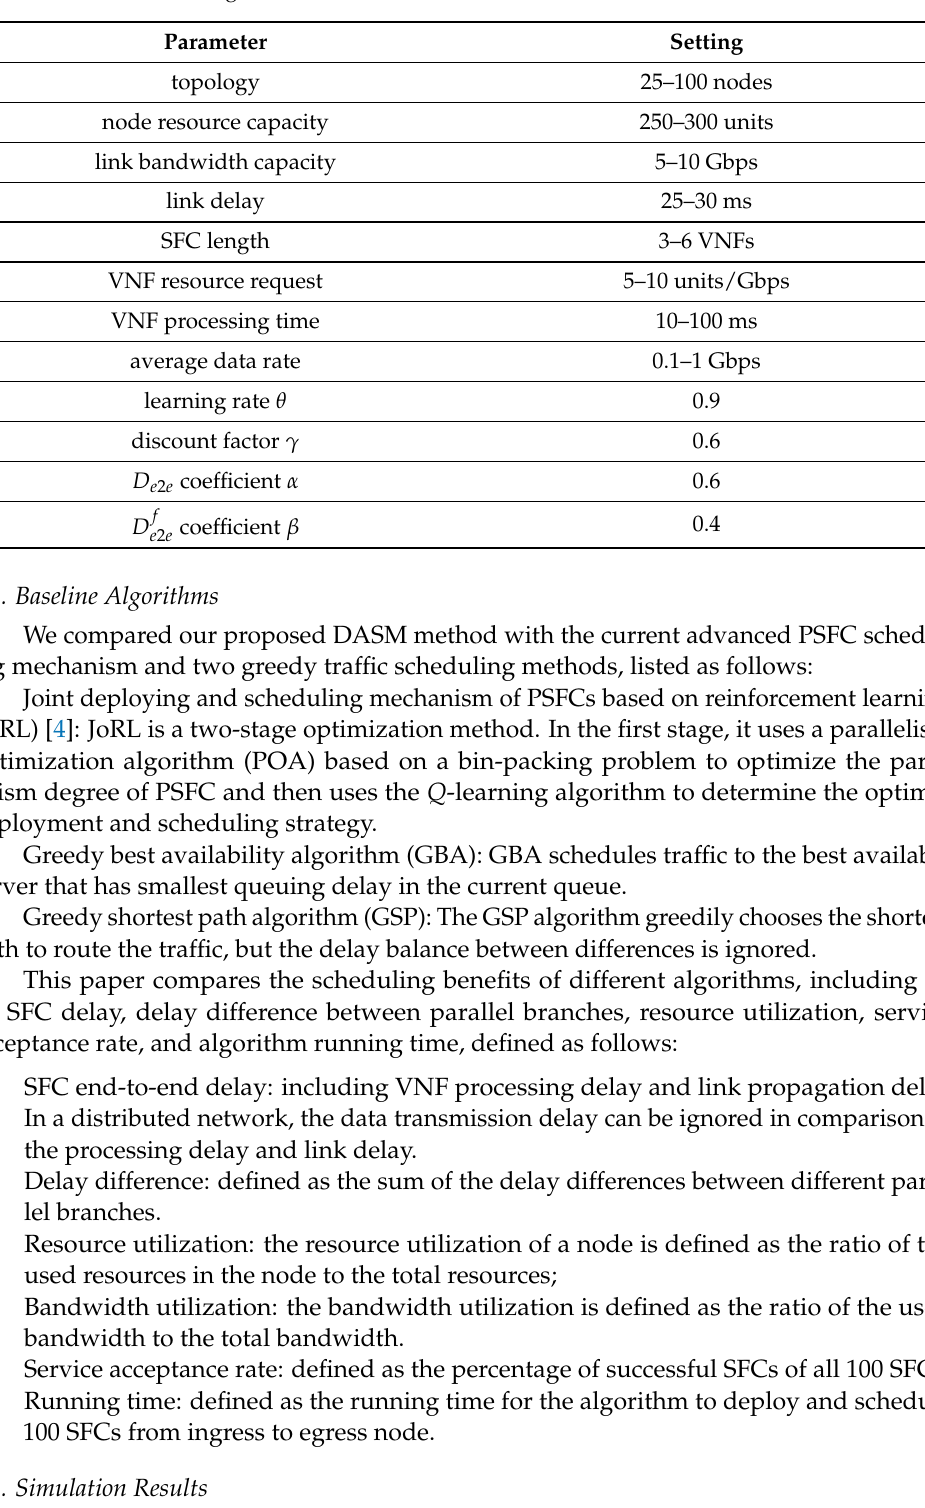
Table 4. Simulation